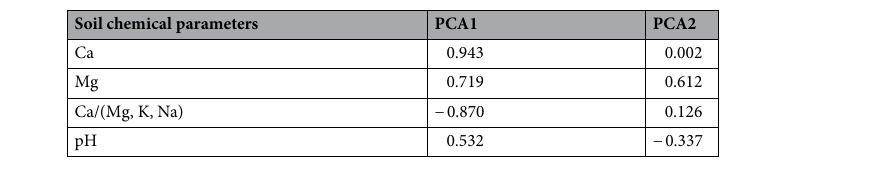
Table 5. Set of correlations coefficients between soil chemical parameters Ca, Mg and pH and two first principal components PCA1 and PCA2.